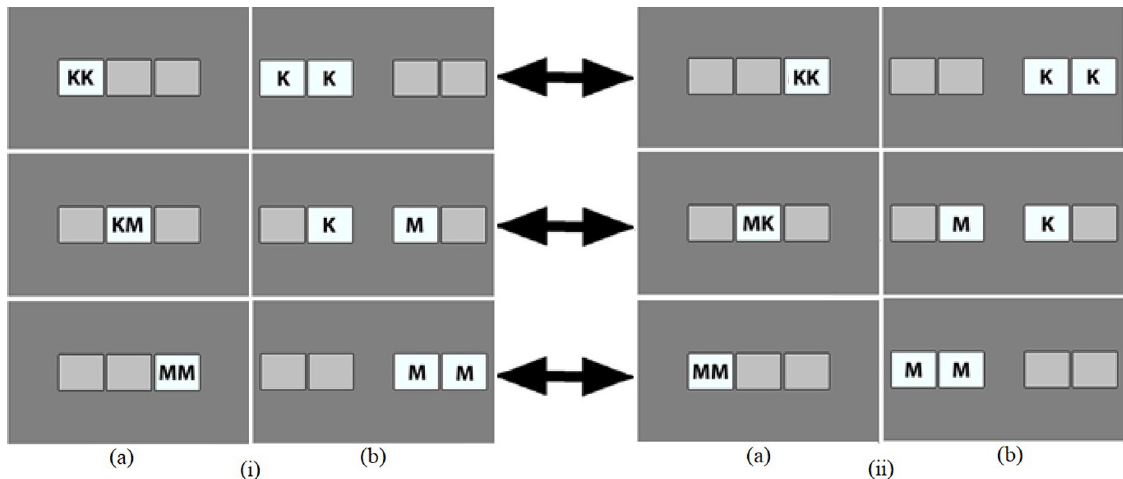
Fig 3. Stimuli used in the Simple Task in the unimanual (a) and bimanual setups (b). Note. Spatial arrangement: (i) KK left/MM right. (ii) MM left/KK